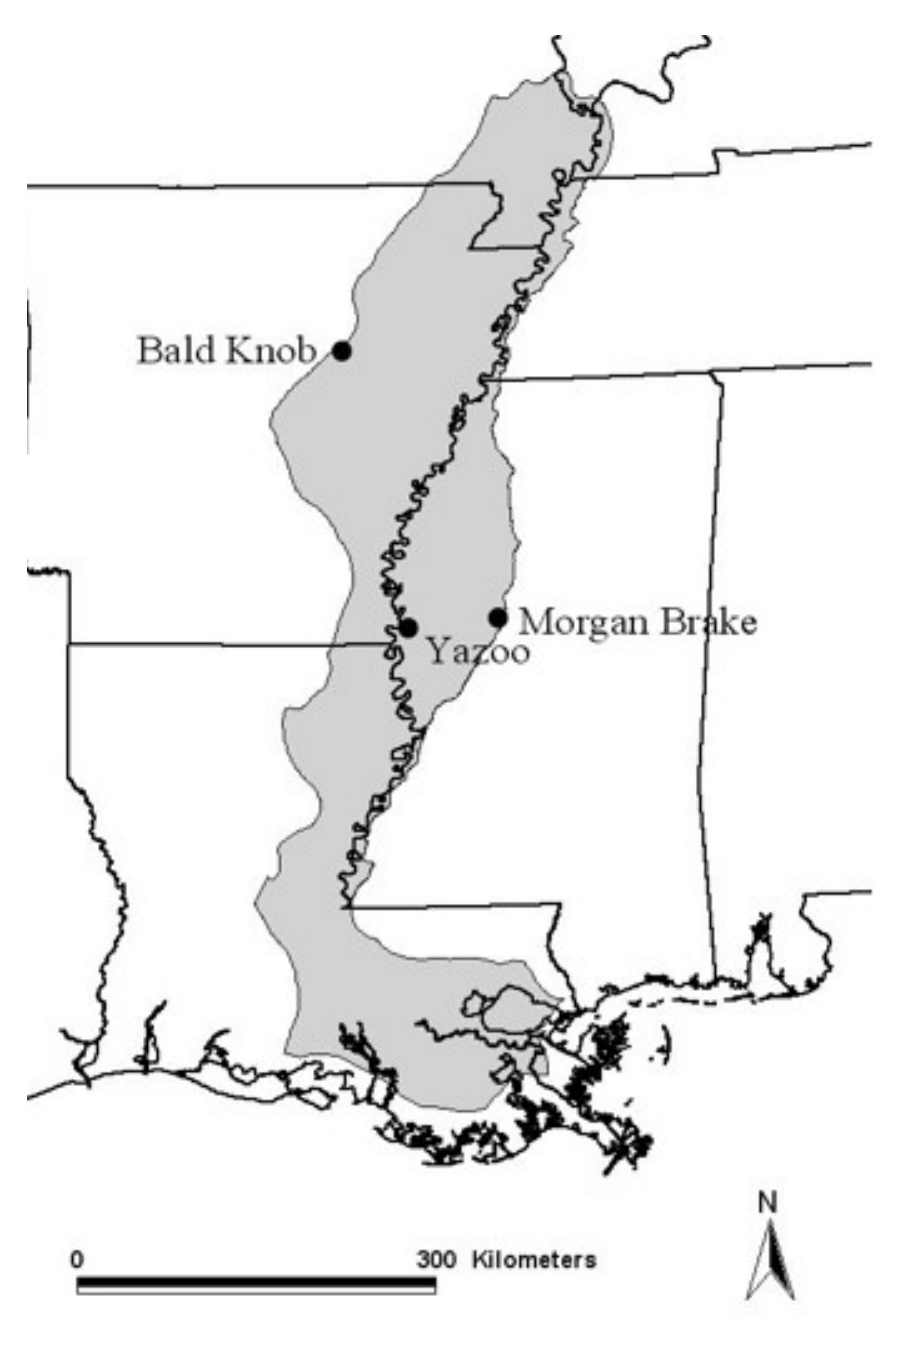
Fig. 1. Study sites in the Lower Mississippi Alluvial Valley during fall